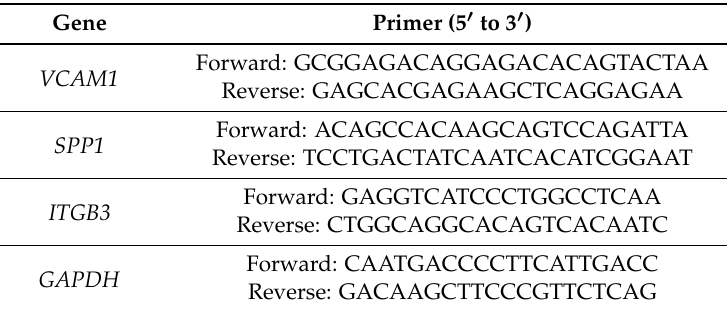
Table 2. Sequence of primers used for Real